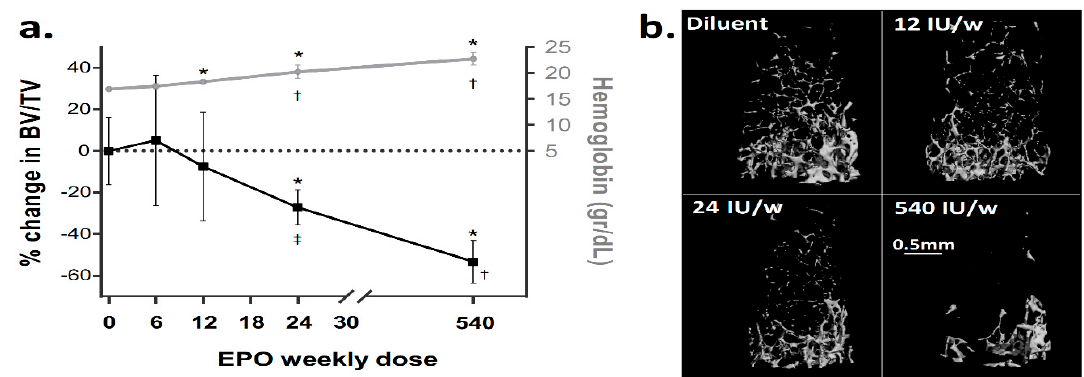
Figure 1. Erythropoietin (EPO) induces dose-dependent trabecular bone loss. a. Relationship between the hemoglobin level (grey) and the extent of reduction in BV/TV (black) at different doses of EPO. The values on the X axis represent a total weekly dose of EPO administered to 10-week-old female mice for two weeks. Values on the Y axis are mean ± SD; n = 3 for 6 and 12 IU, n = 7 and 8 for 24 and 540 IU, respectively. b. Representative 3D reconstruction images of the distal femoral metaphysis of mice treated with diluent or EPO at the designated doses. * p < 0.05 relative to diluent control, † p < 0.05 relative to preceding dose, ‡ p = 0.05 relative to preceding dose.